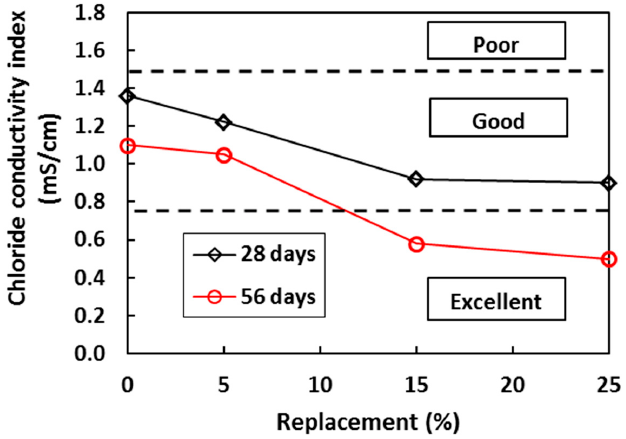
Figure 12. Effect of sugarcane bagasse ash on the chloride conductivity index of concrete [55].